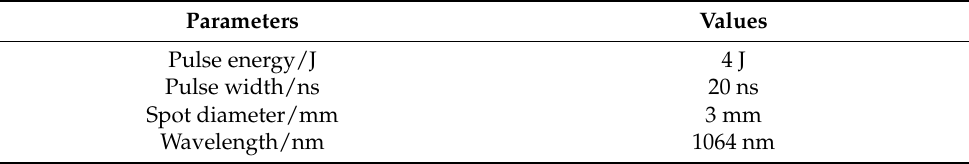
Table 2. Laser shock process parameters.